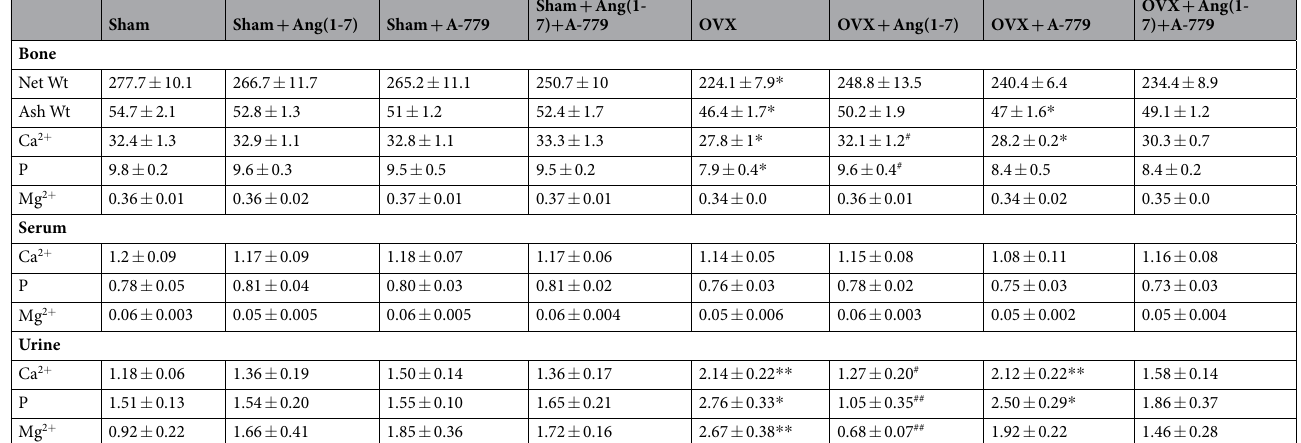
Table 1. Effects of Ang(1-7) and/or A-779 treatments to the sham and OVX animals for 6 weeks on the left femoral net bone and ash weights as well as minerals concentrations in femoral bones, serum and urine in Wistar albino rats. The net bone weights were expressed as mg/100 g body weight, while ash weights were expressed as mg/100 mg net bone weight. The concentrations of minerals including Ca 2 + , P and Mg 2 + were measured by ICP-MS and expressed as mg/100 mg Ash in bone, mmol/L in serum, and mmol/mmol creatinine in urine. One-way ANOVA test followed by post hoc Student-Newman-Keuls multiple comparisons test were used for the statistical analysis. Data are expressed as mean ± SEM of each group (n = 8/group). Statistical significance was considered when * P < 0.05 and ** P < 0.01 as compared to Sham group and # P < 0.05 and ## P < 0.01 as compared to OVX